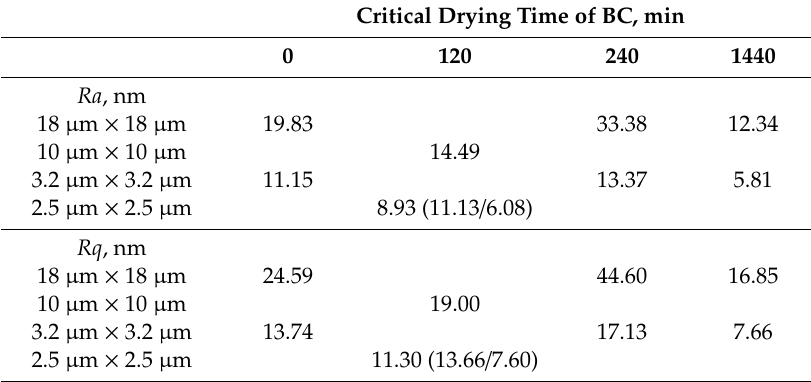
Table 3. Roughness parameters obtained from AFM